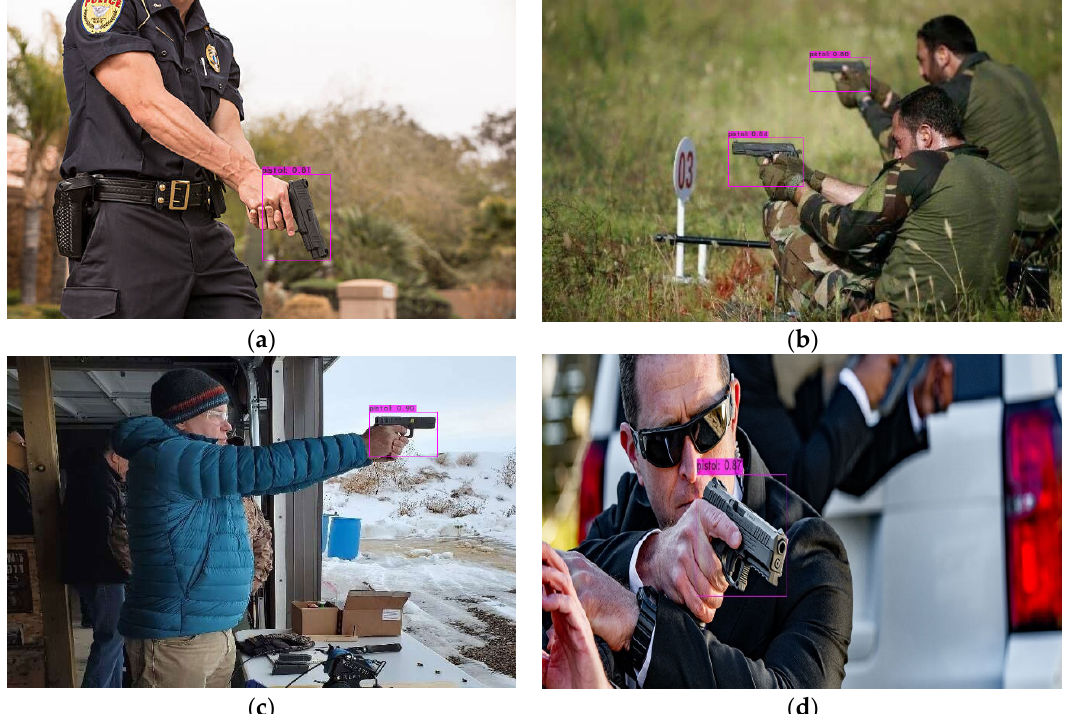
Figure 17. Detection results of Scaled-YOLOv4 with background. ( a ) Image with pistol as a weapon held vertically down. ( b ) Image with multiple pistols as a weapon aimed horizontally showing left side angle. ( c ) Image with a pistol as a weapon aimed horizontally showing right side angle. ( d ) Image with a pistol as a weapon held diagonally showing front and side angles.